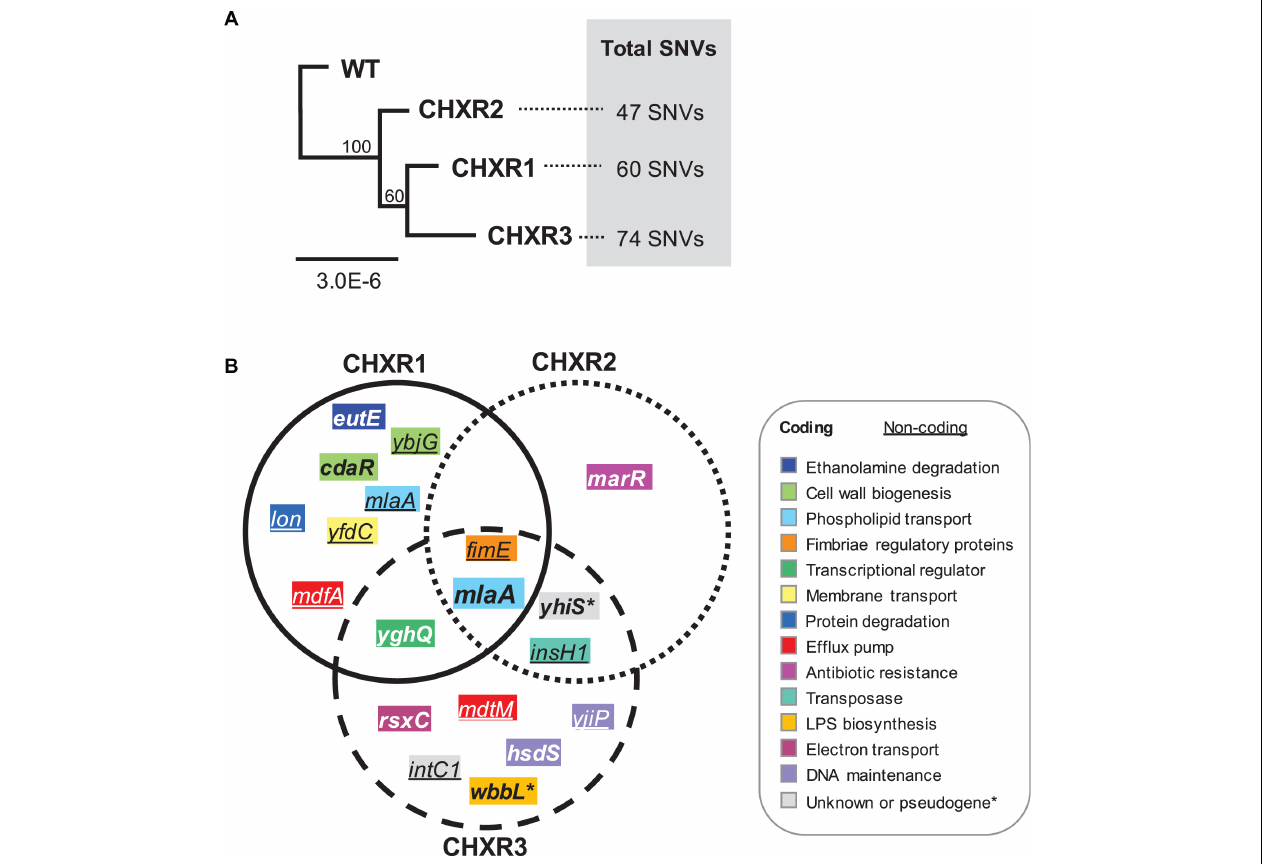
FIGURE 5 | Phylogenetic analysis of CHXR isolate genomes and a Venn diagram summary of coding and non-coding SNVs identified in each CHXR isolate. (A) A Maximum Likelihood dendrogram of aligned WGS WT and CHXR1-3 sequences, where bootstrap confidence values are indicated at each node. Total SNVs identified from genomic comparisons of each CHXR isolate to the WT is indicated on the right-hand side of the dendrogram. (B) A Venn diagram summary highlighting SNVs identified in the coding genes and non-coding upstream regions of genes (underlined) identified from CHXR isolates by WGS. The gene names shown in the diagram are color-coded according to their functional association as shown in the panel legend.